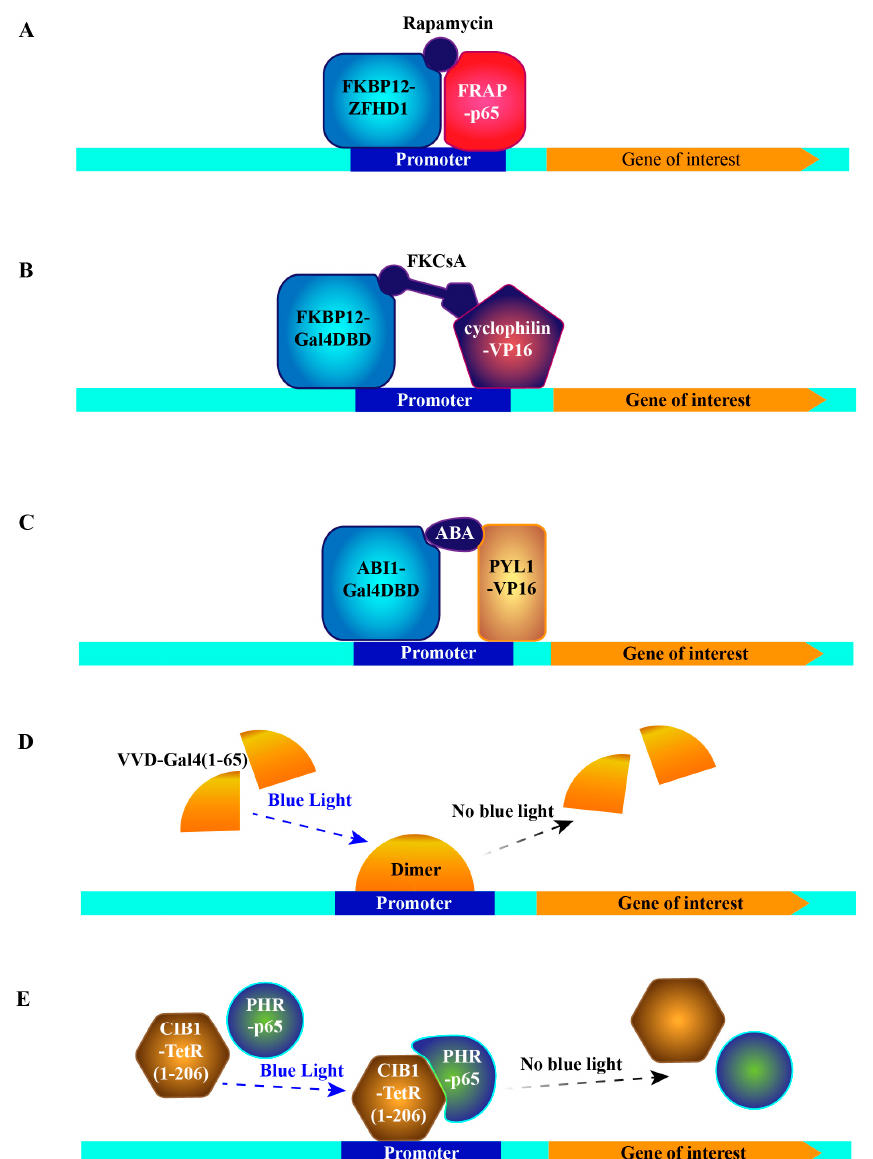
Figure 3. Schematic representations of protein–protein interaction based systems. ( A ) Inducible system dependent on rapamycin induced interaction between FKBP12 and FRAP. ( B ) Inducible system dependent on FKCsA induced interaction between FKBP12 and cyclophilin. ( C ) Inducible system dependent on ABA induced interaction between PYL1 and ABI1. ( D ) Inducible system dependent on blue light induced VVD dimer formation. ( E ) Photoactivatable-Tet-OFF / ON system dependent on blue light induced interaction between Cry2 and CIB1. Gal4DBD: Gal4 DNA binding domain, ABA: abscisic acid, TetR: tet repressor.